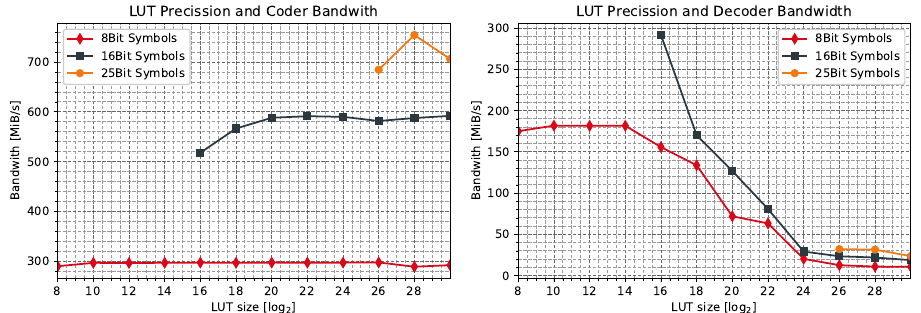
Figure 5: E ff ects of LUT precision on coding bandwidth.